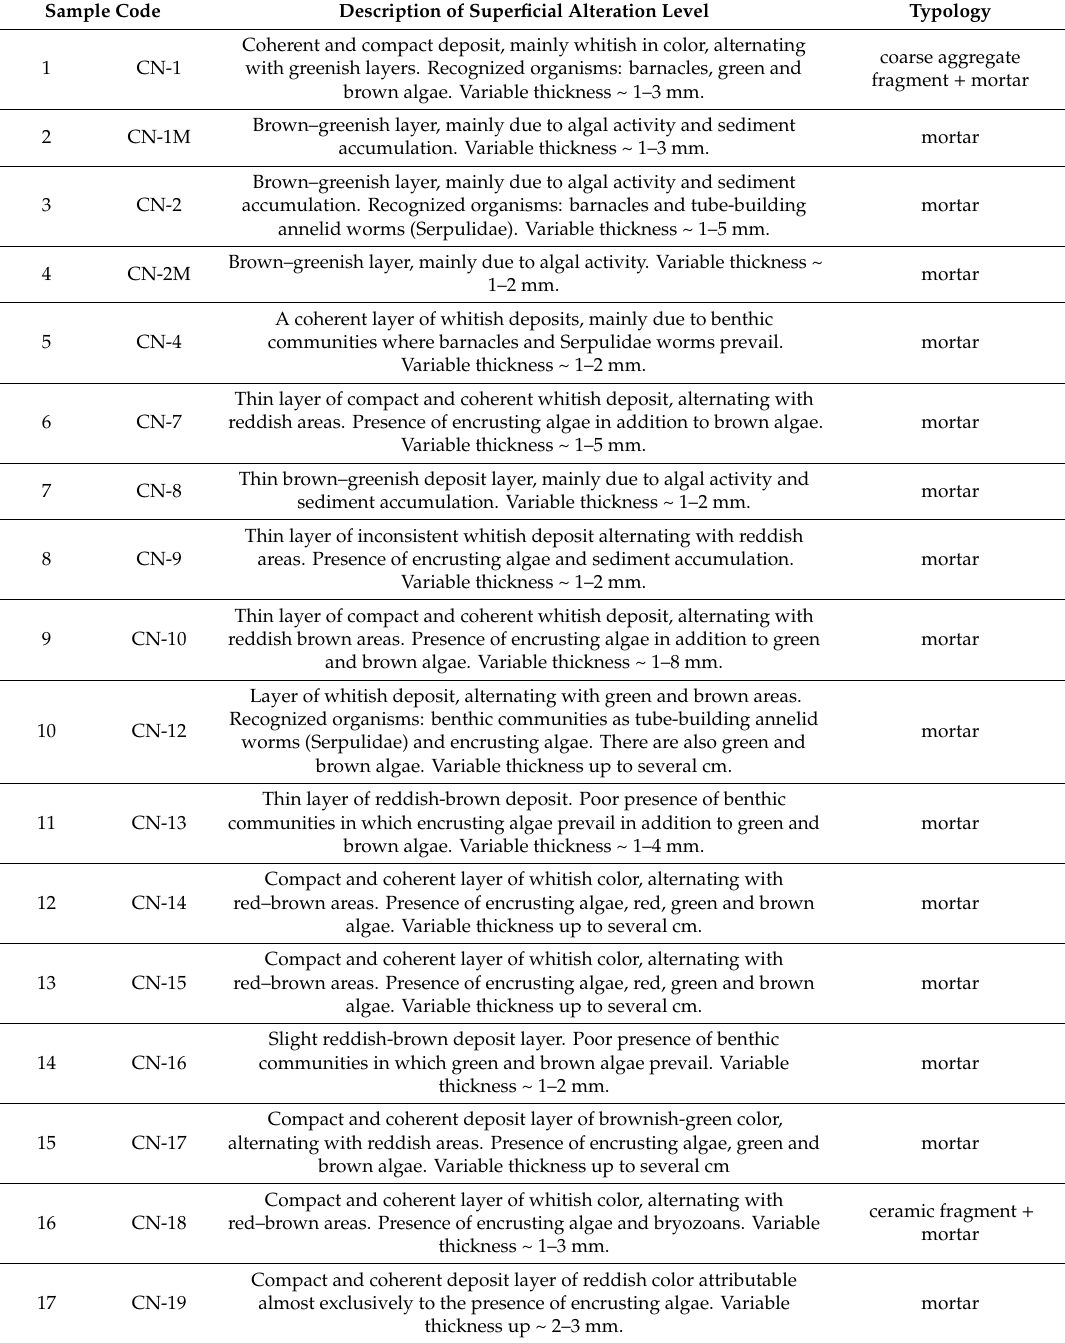
Table 1. Samples and description of alteration